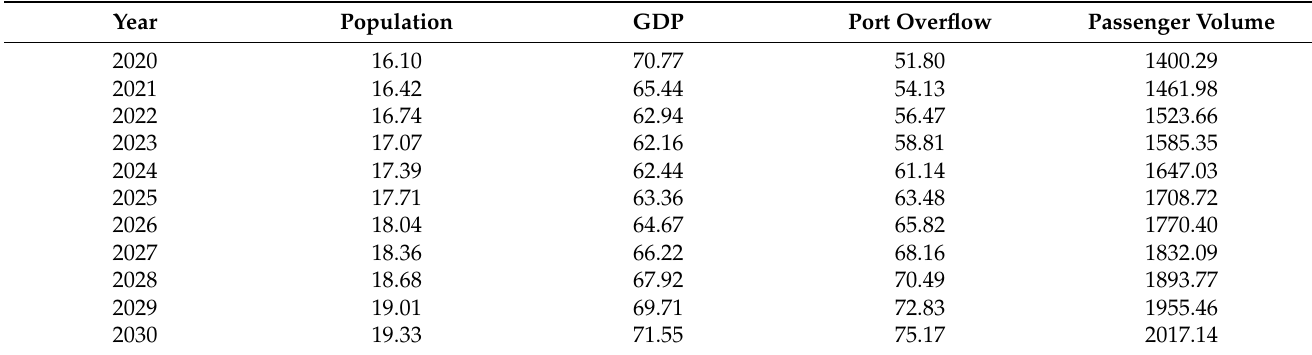
Table 5. Population, GDP, passenger volume, and shipment forecast from 2020 to